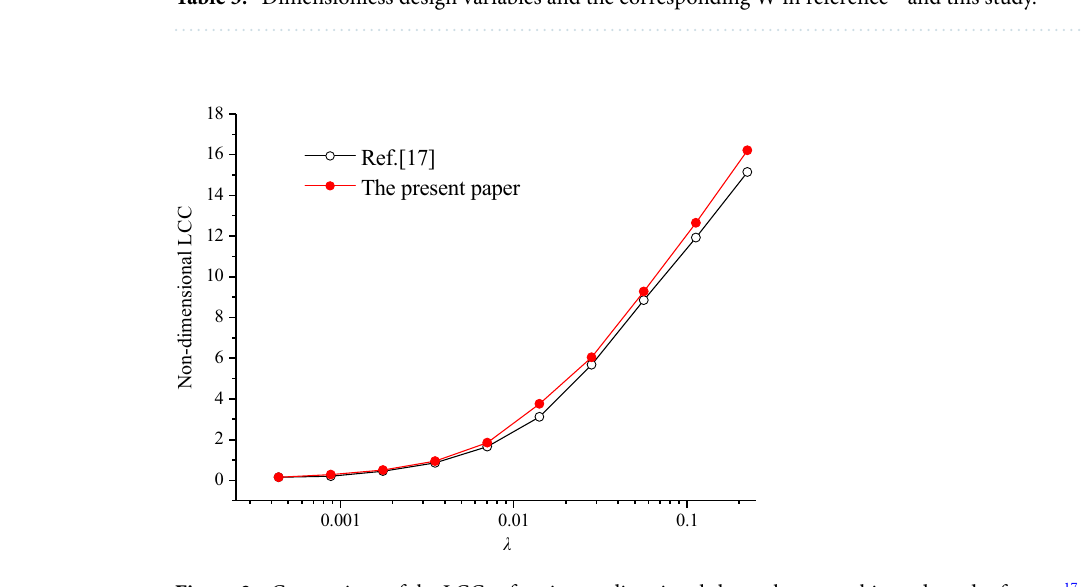
Table 3. Dimensionless design variables and the corresponding W in reference 17 and this study.